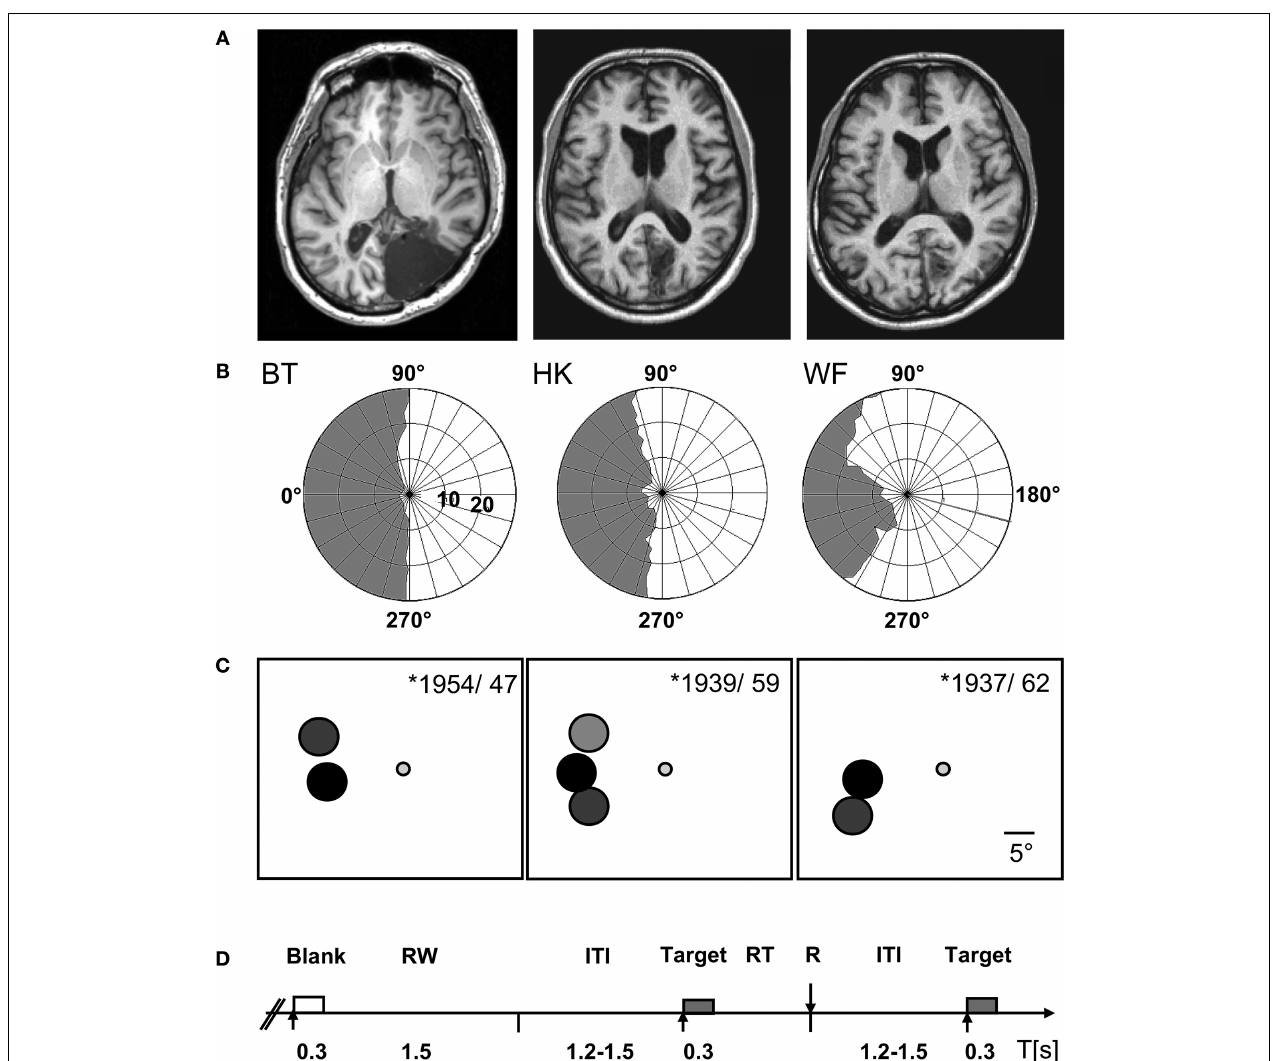
FIGURE 1 | Patient and experimental information. (A) T1-weighted magnetic resonance images depicting the lesions in the right occipital lobe. (B) The visual fi elds of the left eye are plotted to an eccentricity of ± 30 ° . They were mapped at a Tübinger perimeter (Oculus, Wetzlar, Germany) using a combination of dynamic and static (200 ms presentation) perimetry. Stimuli were white 116 ′ , 320 cd/m 2 circular targets presented on a 10 cd/m 2 neutrally white background. (C) The positions used for testing detection are shown on a cartoon screen. They had